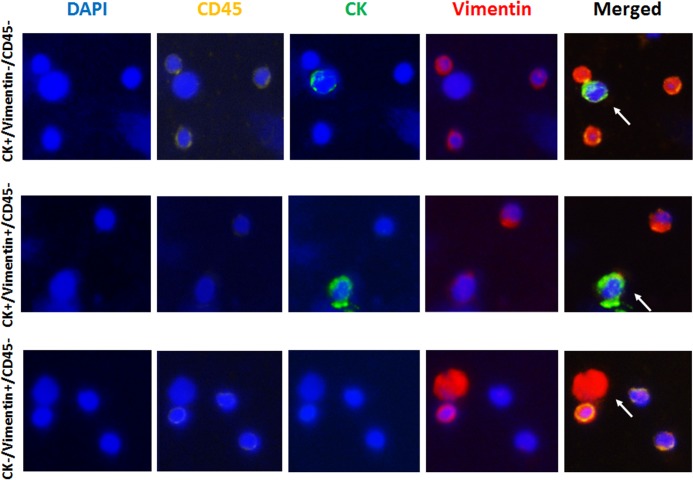
Representative images for different types of detected cells in prostate cancer patients.(A) A CK positive/Vimentin negative/CD45 negative cell surrounded by CD45 positive lymphocytes. (B) A CK positive/Vimentin positive/CD45 negative cell next to a CD45 positive lymphocyte. (C) A CK negative/Vimentin positive/CD45 negative cell surrounded by CD45 positive lymphocytes.